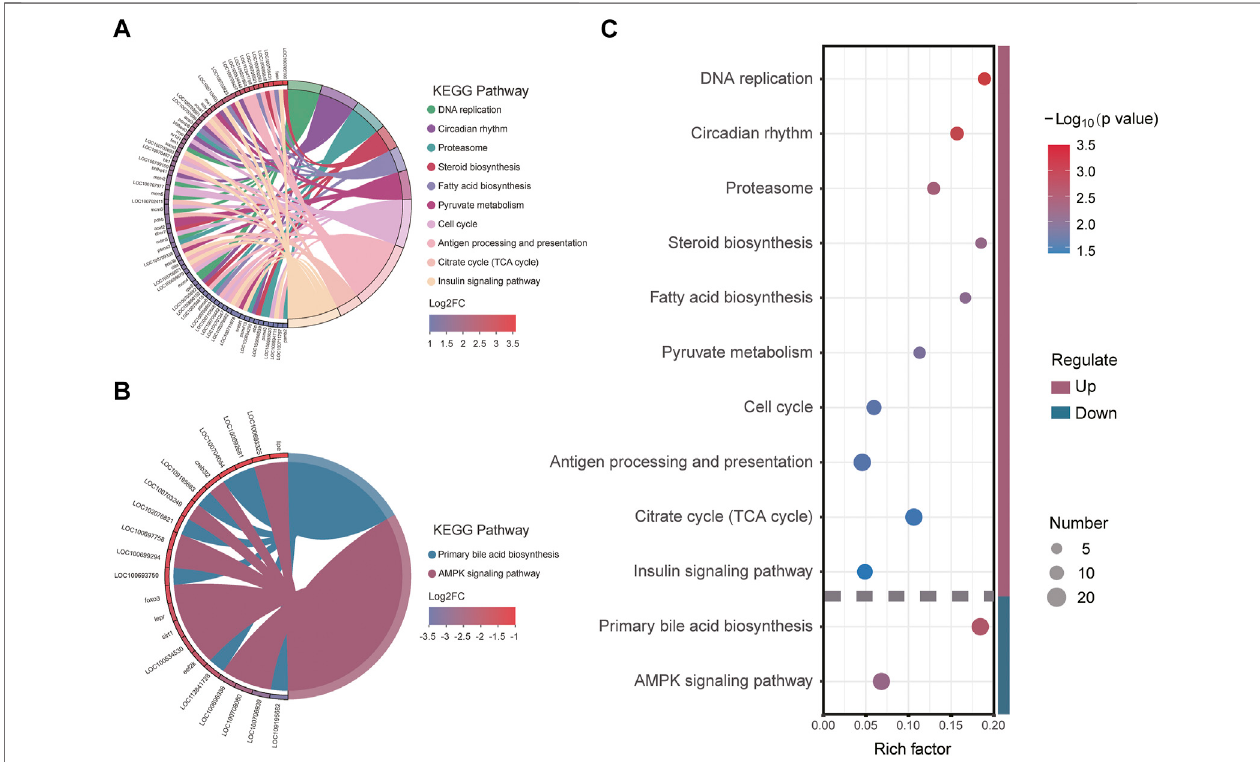
FIGURE 5 | Kyoto Encyclopedia of Genes and Genomes (KEGG) pathway enrichment and its major enrichment genes: (A) upregulated differentially expressed genes (DEGs) signi fi cantly enriched; (B) downregulated DEGs signi fi cantly enriched; (C) signi fi cantly enriched KEGG pathways and the Rich factors.